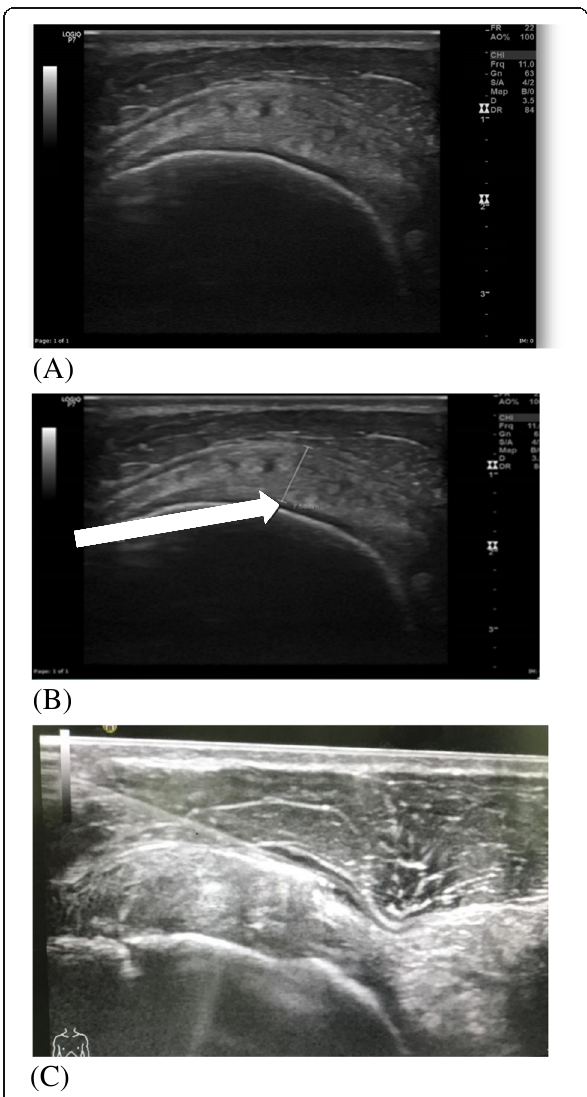
Fig. 3 a Right shoulder ultrasound with diffuse supraspinatus thickening and heterogenicity. b Baseline supraspinatus tendon thickness (white arrow). c Ultrasound-guided injection of PRP in the right subacromion